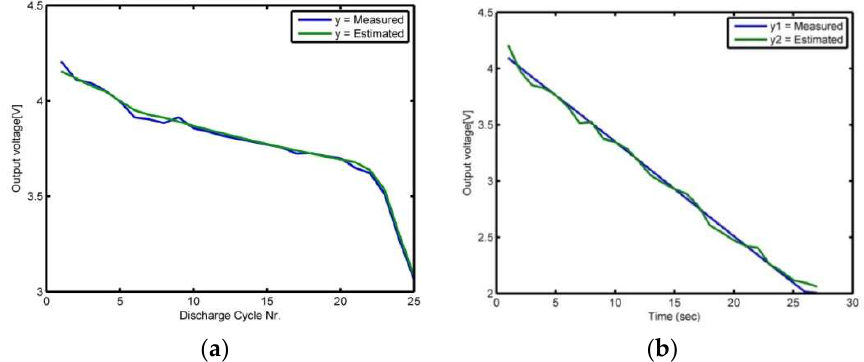
Figure 5. Measured and estimated terminal voltages: ( a ) Battery measured and estimated output terminal voltage; ( b ) the measured and estimated output terminal voltage of the supercapacitor.